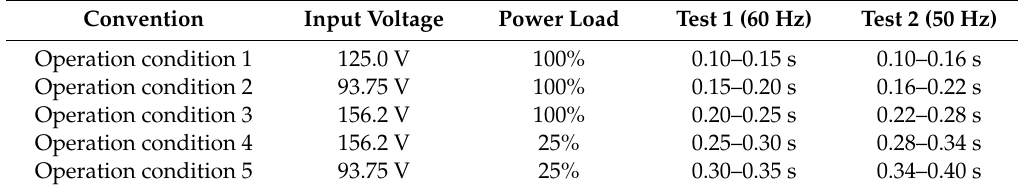
Table 4. Operation conditions and time intervals used in simulation tests.